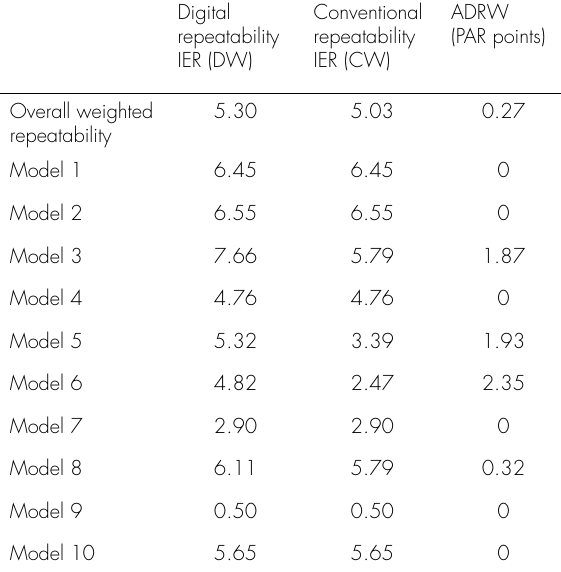
Table III. Carstensen analysis for unweighted PAR